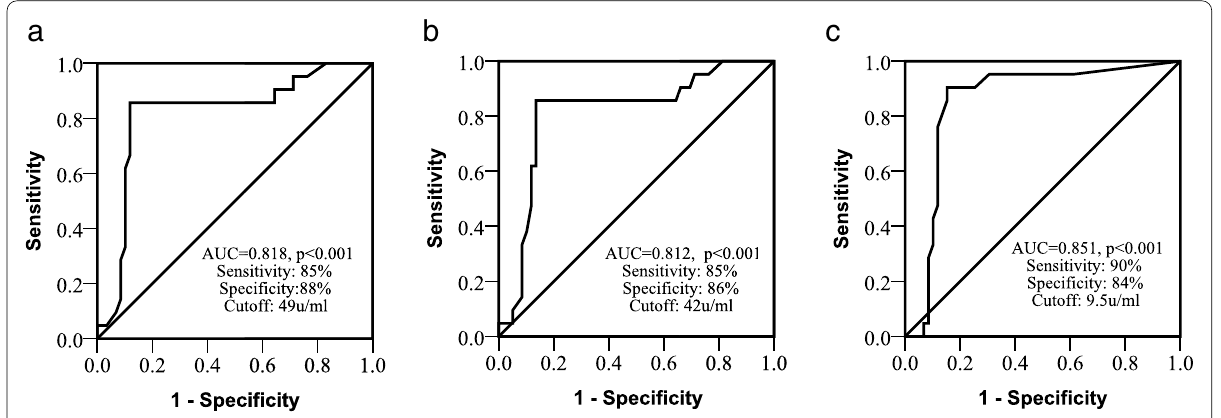
Fig. 2 ROC curve analysis of autoantibodies. a Anti‑dsDNA. b Anti‑nucleosome. c